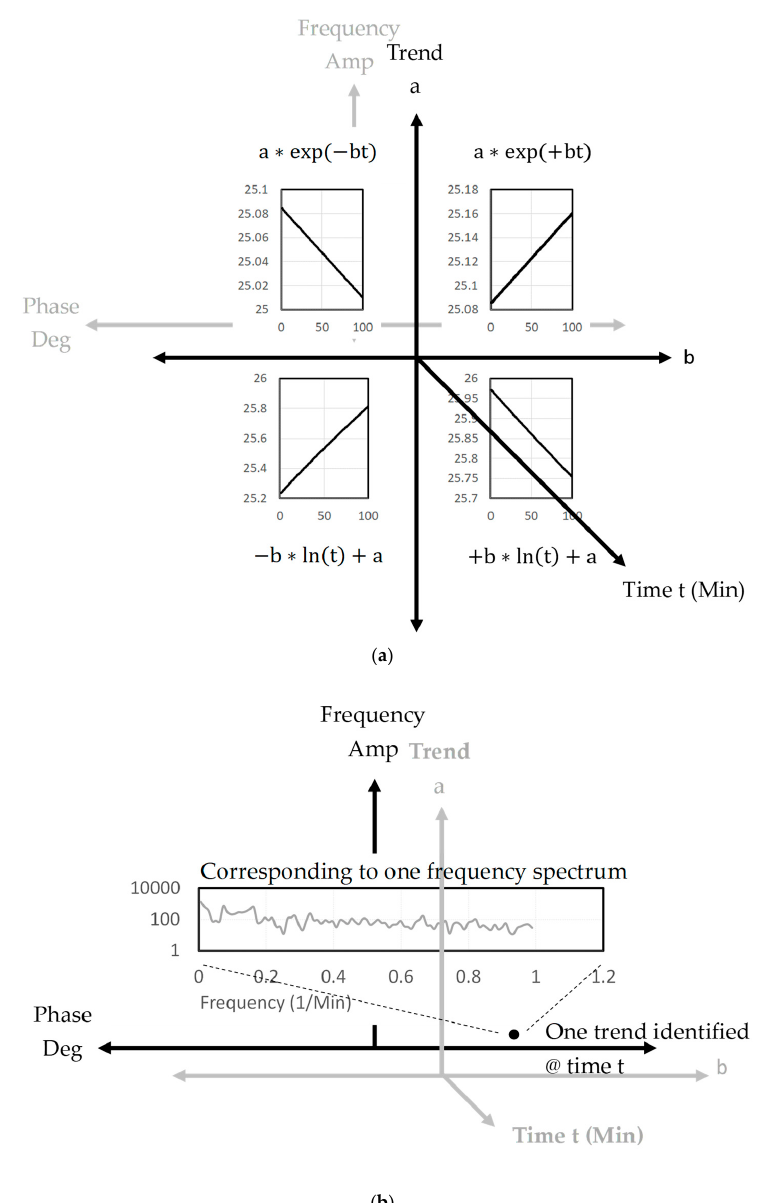
Figure 5. Two features of big data, including ( a ) the signal trend, can be expressed by four standard types; ( b ) one frequency spectrum corresponding to one signal